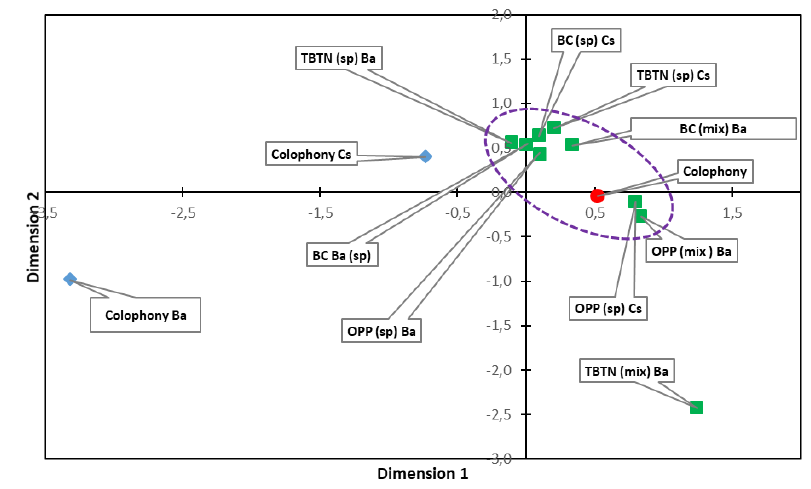
Figure 4. Multidimensional scaling (MDS) analysis of the colophony samples: blank sample (type 1, red circle); samples inoculated with microorganisms without biocide (type 3, blue diamonds); and samples inoculated with Cs and Ba, and treated with the studied biocides (type 4 (mix), and 5 (sp), green squares). BC = benzalkonium chloride, TBTN = tributyltin naphtenate, and OPP = ortophenyl phenol. Cs = C. sitophila ; Ba = B. amyloliquefaciens .